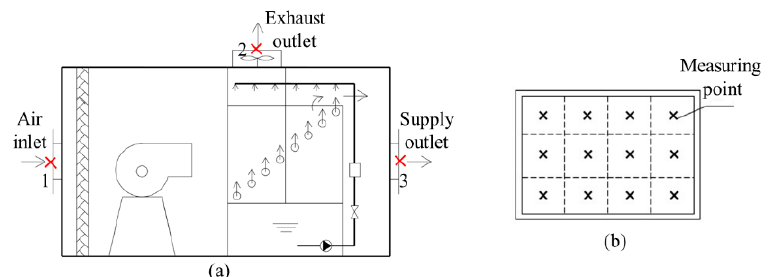
Figure 2. Schematic diagram of the measuring points: ( a ) unit measuring points; ( b ) air speed measuring